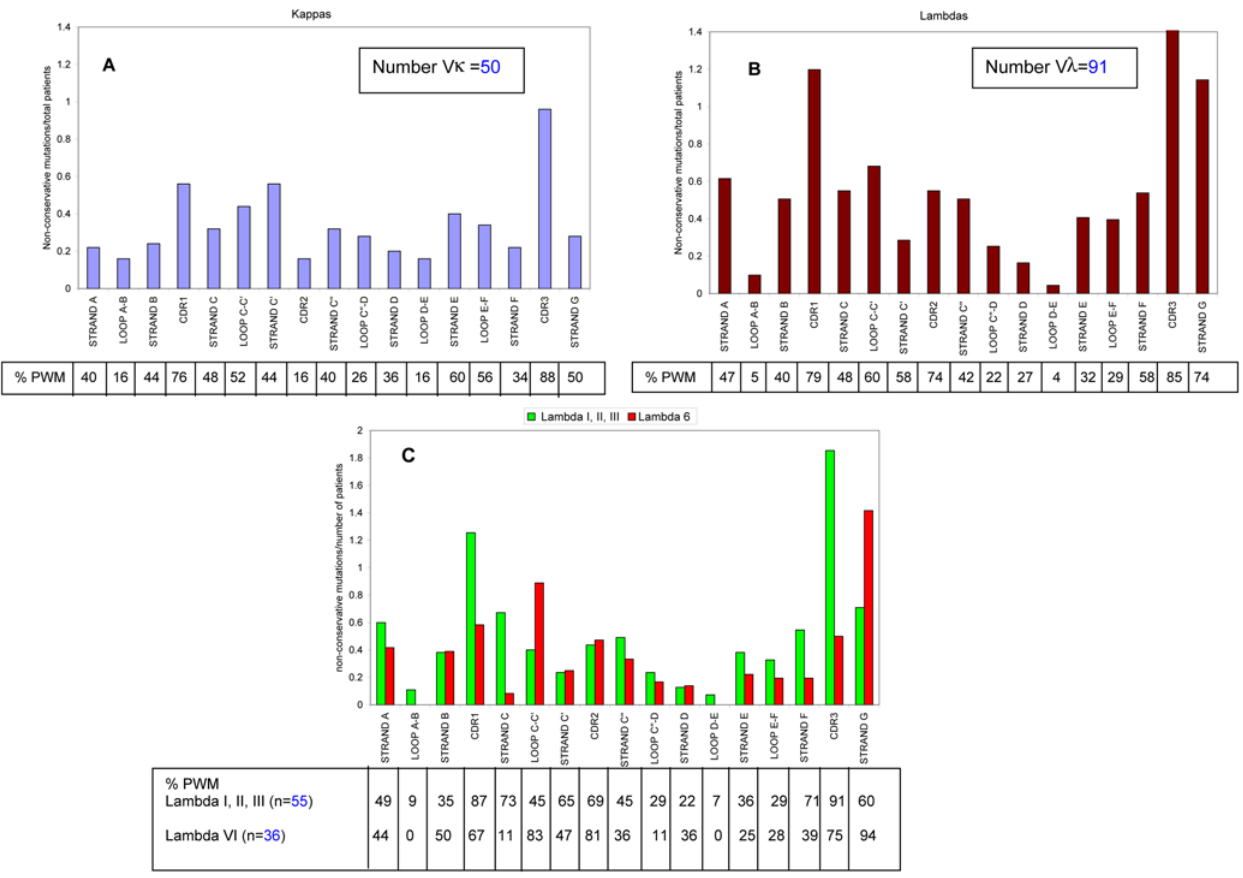
Figure 2. Non-conservative mutations over total number of patients for each secondary structure element for AL V l and V k proteins. The x-axis shows the different elements of secondary structure in the VL, while the y-axis gives the ratio of non-conservative mutations in each secondary structure element per total number of patients. The secondary structure boundaries used were based on the germline donor for each protein. Numbering is based on Kabat (http://vbase.mrc-cpe.cam.ac.uk/). A) V k sequences. B) V l sequences. C) Comparison of V l VI and other lambdas (V l I, II and III). The percentage of patients with mutations (% PWM) in each secondary structure element is listed per group.